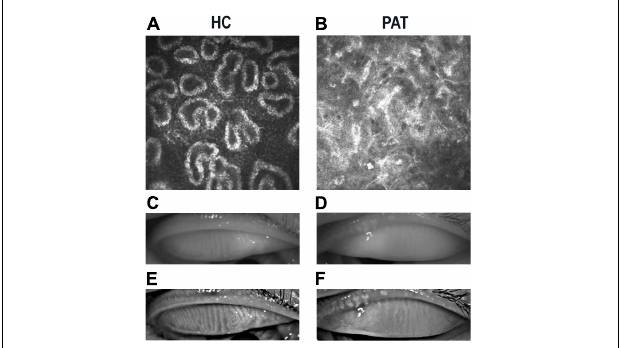
FIGURE 1 | Representative manifestations of meibomian gland in HCs and PATs. Meibomian gland photographed under corneal confocal microscopy in HC (A) and PAT (B) . Significant blockage of meibomian glands in PAT group. Photograph of meibomian gland as seen by the naked eye in HC (C) and PAT (D) . Infrared photography of meibomian gland in HC (E) and PAT (F) . Clearer meibomian gland in HC group. Abbreviations: HC, healthy control; PAT, severely obese patients with meibomian gland